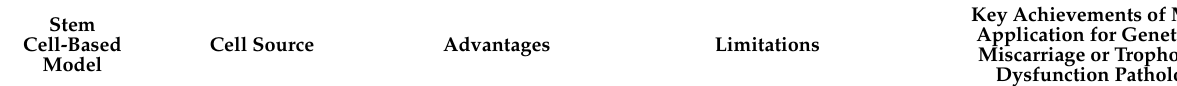
Table 1. Advantages and limitations of stem cell-based trophoblast